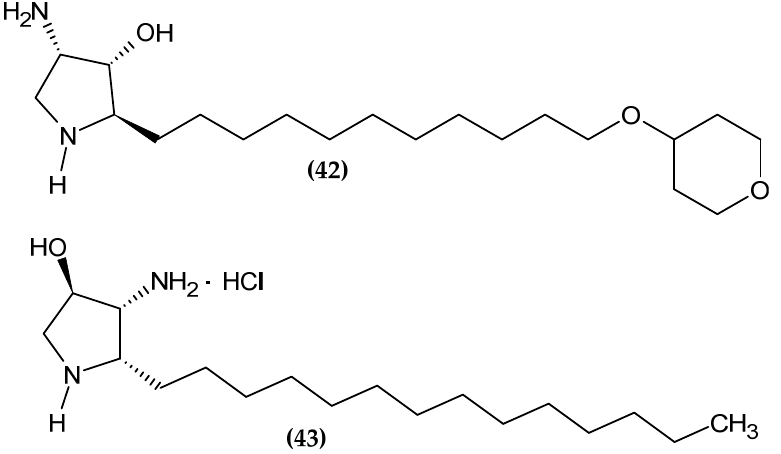
Figure 10. Jaspine B derivatives with anti-melanoma activity.